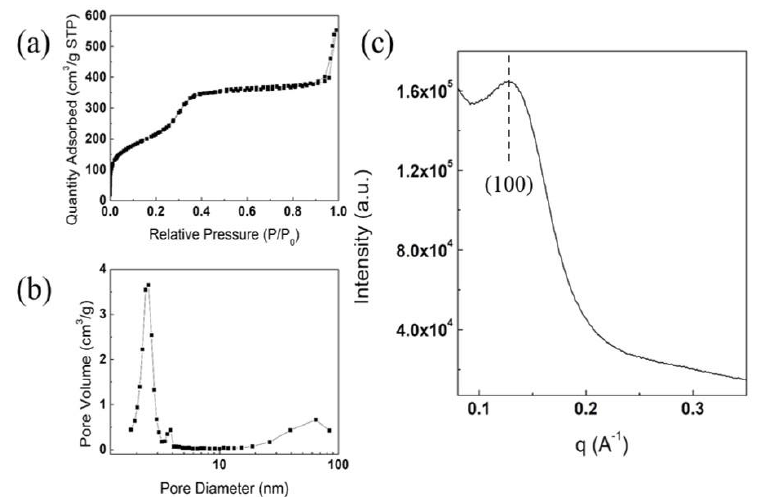
Figure 9. N 2 -physisorption and SAXS results: ( a ) N 2 -adsorption isotherm and ( b ) pore size distribution curve; ( c ) small-angle X-ray scattering pattern of spent χ -Fe 5 C 2 @SiO 2 _H catalyst after reaction.